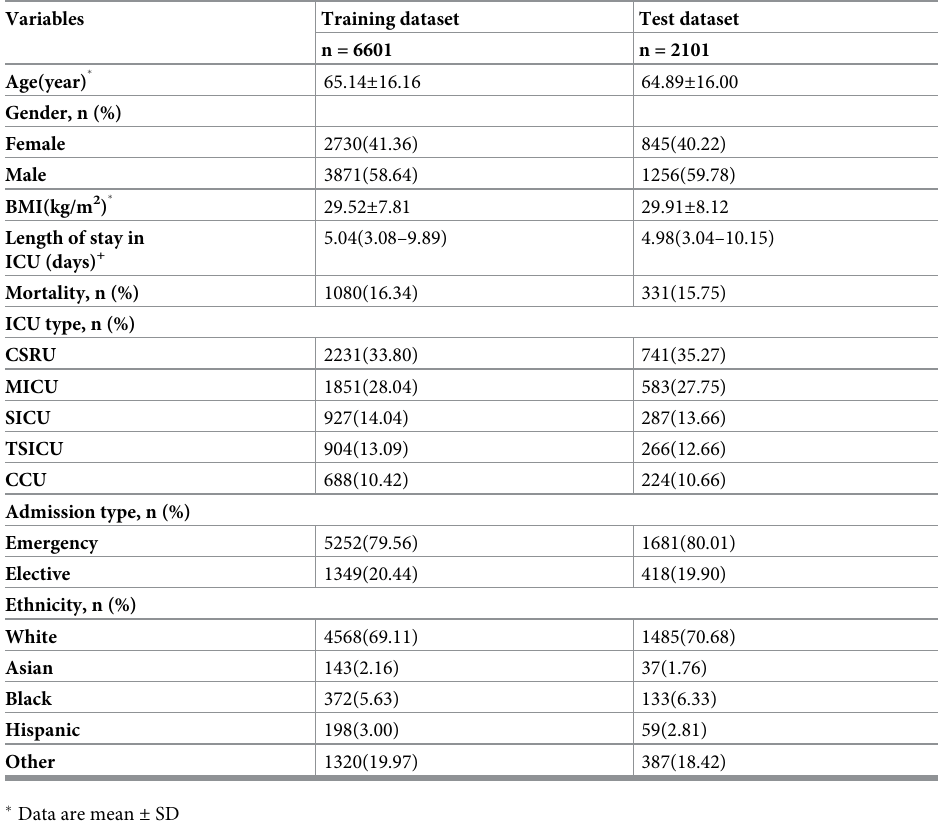
Table 2. Patient demographics in training and test sets (ICU: Intensive Care Unit, CSRU: Cardiac Surgery Recov- ery Unit, MICU: Medical Intensive Care Unit, CCU: Coronary care unit, SICU: Surgical intensive care unit, TSICU: Trauma Surgical Intensive Care